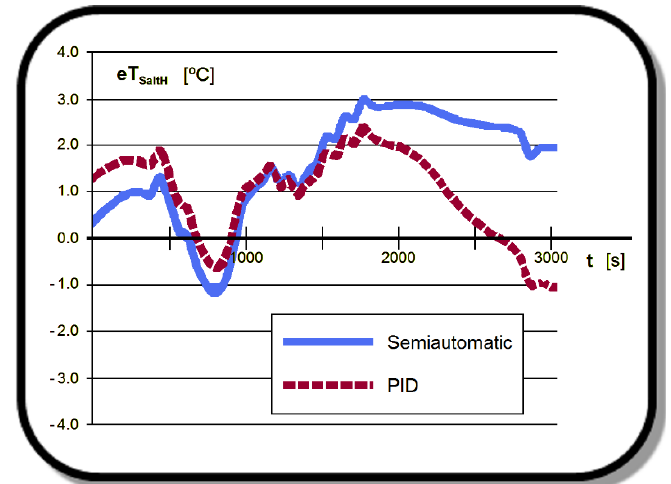
Figure 12. Simulation of the hot salt temperature error obtained during the charge